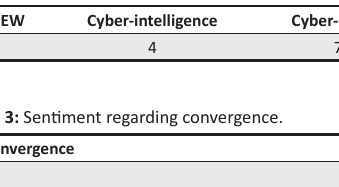
TABLE 2: Mentions of areas converging.